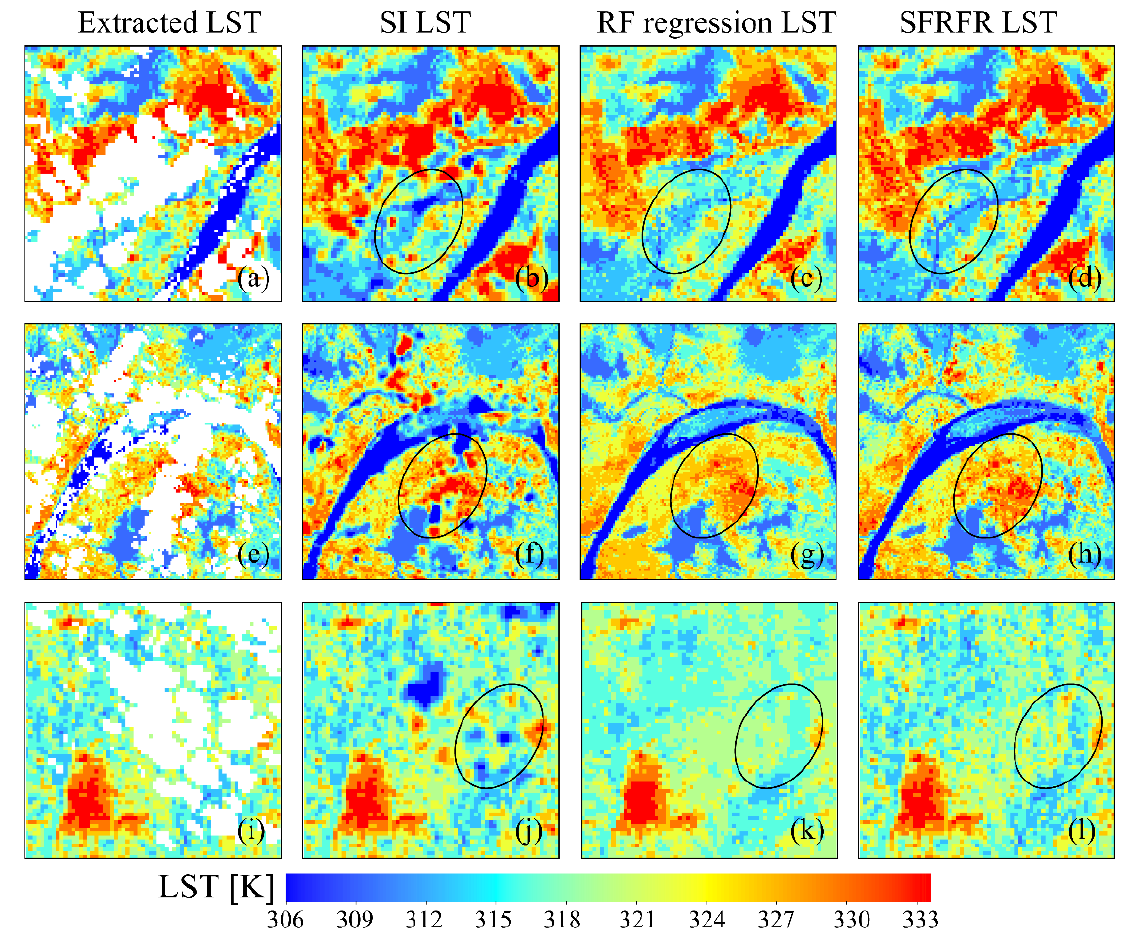
Figure 14. Visual performances of the reconstructed LST and the extracted LST at a 250 m spatial resolution: ( a ) extracted LST, ( b ) SI LST, ( c ) RF regression LST, ( d ) SFRFR LST, ( e ) extracted LST, ( f ) SI LST, ( g ) RF regression LST, ( h ) SFRFR LST, ( i ) extracted LST, ( j ) SI LST, ( k ) RF regression LST, and ( l ) SFRFR LST.